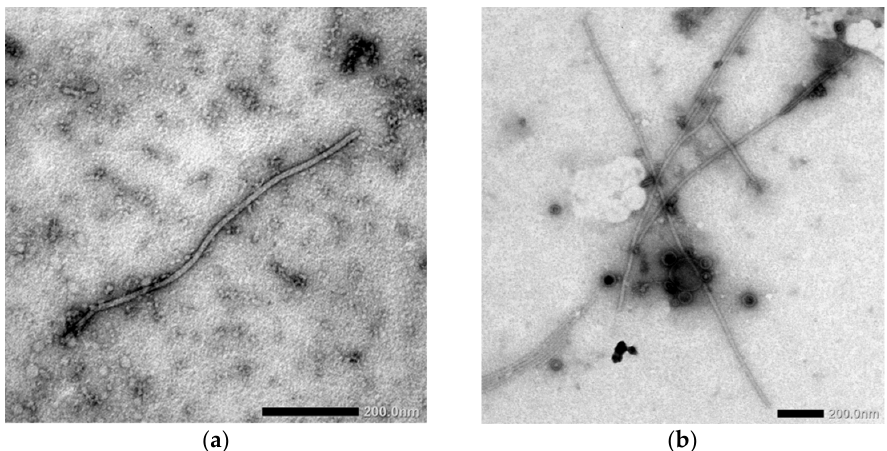
Figure 4. Morphology of viruses detected in sap of symptomatic winter wheat plants as detected by transmission electron microscopy: wheat streak mosaic virus (WSMV) monoinfection ( a ) and mixed infection of WSMV + High Plains wheat mosaic virus (HPWMoV) ( b ). Bars are indicated on images.